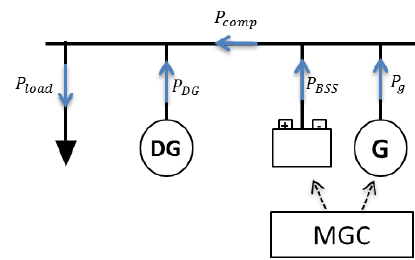
Fig. 1. Island grid consisting of consumers (load), distributed renewable energy sources (DG), gensets, battery storage systems (BSS) and a microgrid controller